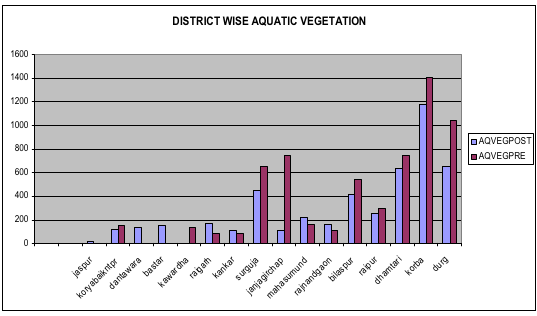
Figure 8. shows the statistics of the wetland features obtained for different districts Chhattisgarh